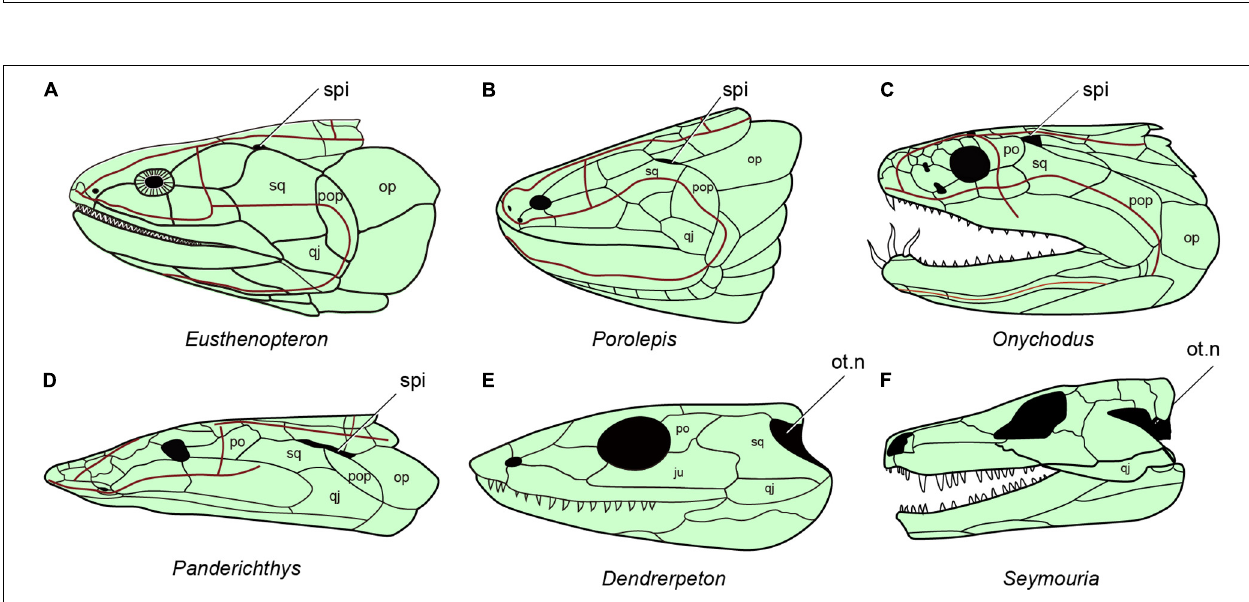
FIGURE 7 | The distribution of spiracles in bony fishes and tetrapods. (A) Eusthenopteron , redraw after (Jarvik, 1980). (B) Porolepis redraw after (Janvier, 1996b). (C) Onychodus redraw after (Long, 2001). (D) Panderichthys redraw after (Vorobyeva and Schultze, 1991). (E) Carboniferous tetrapod Dendrerpeton redraw after (Carroll, 1967). (F) Seymouria redraw after (White, 1939), (A–F) , in lateral view.